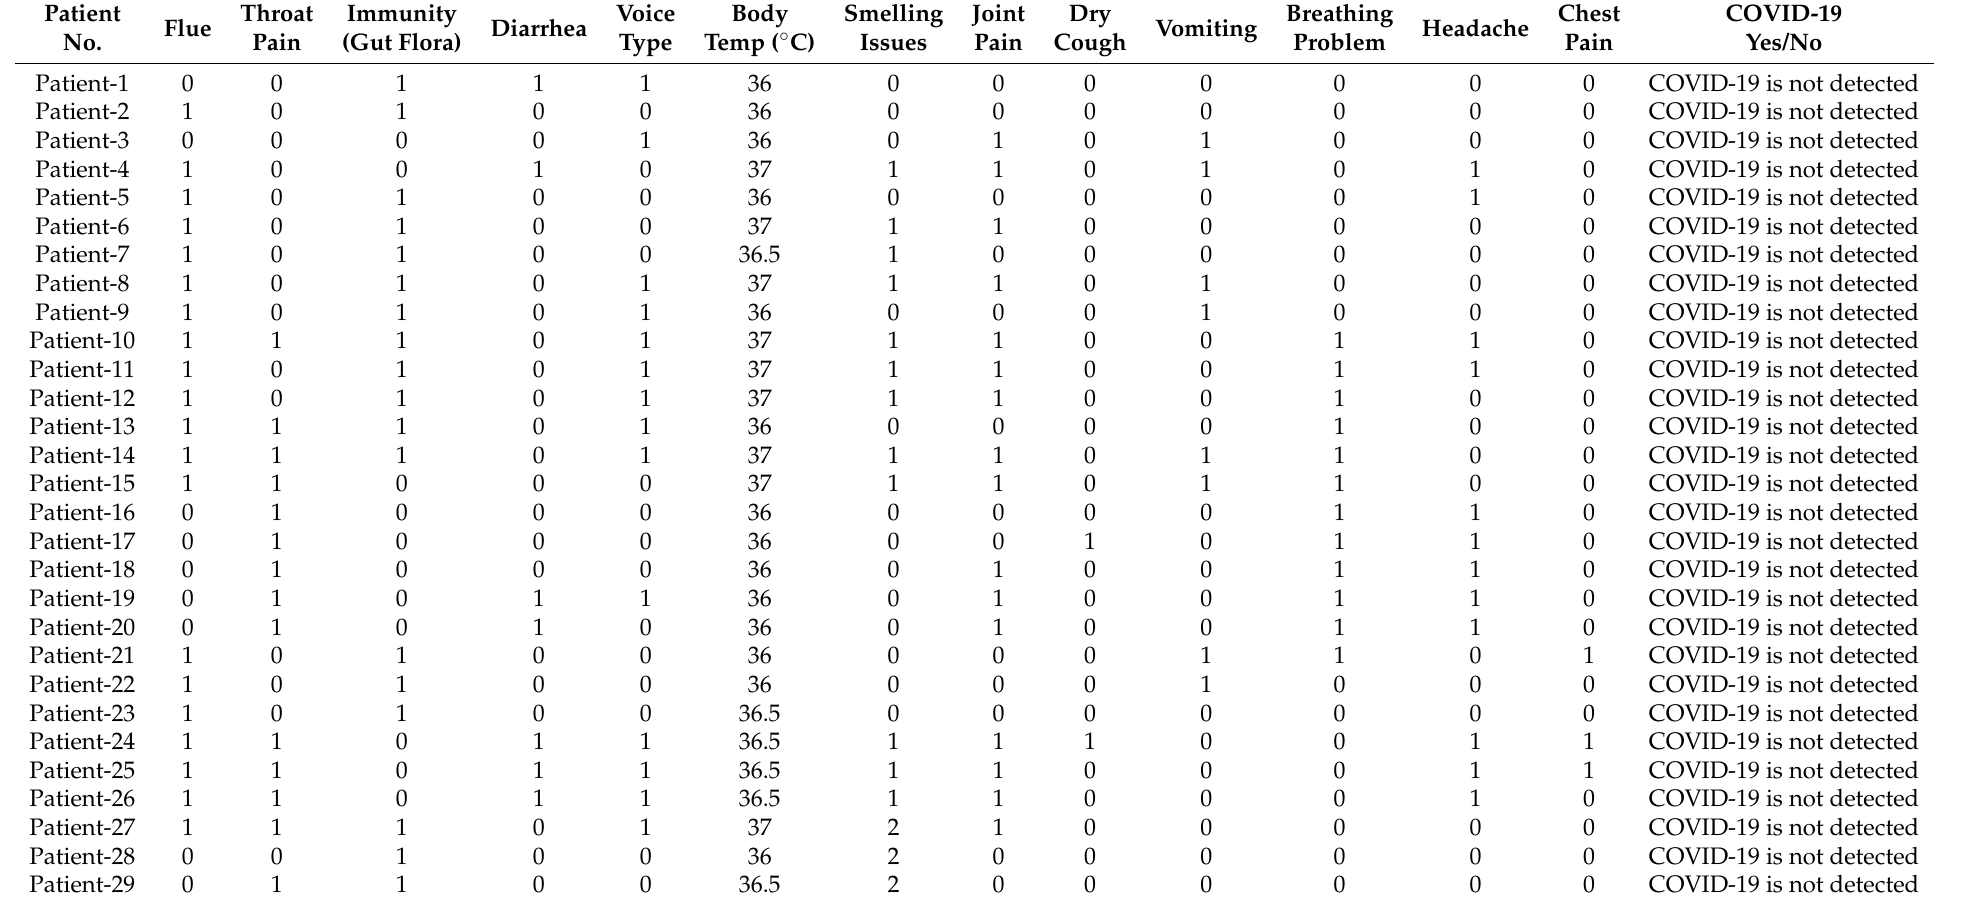
Table 1. Some portion of the proposed